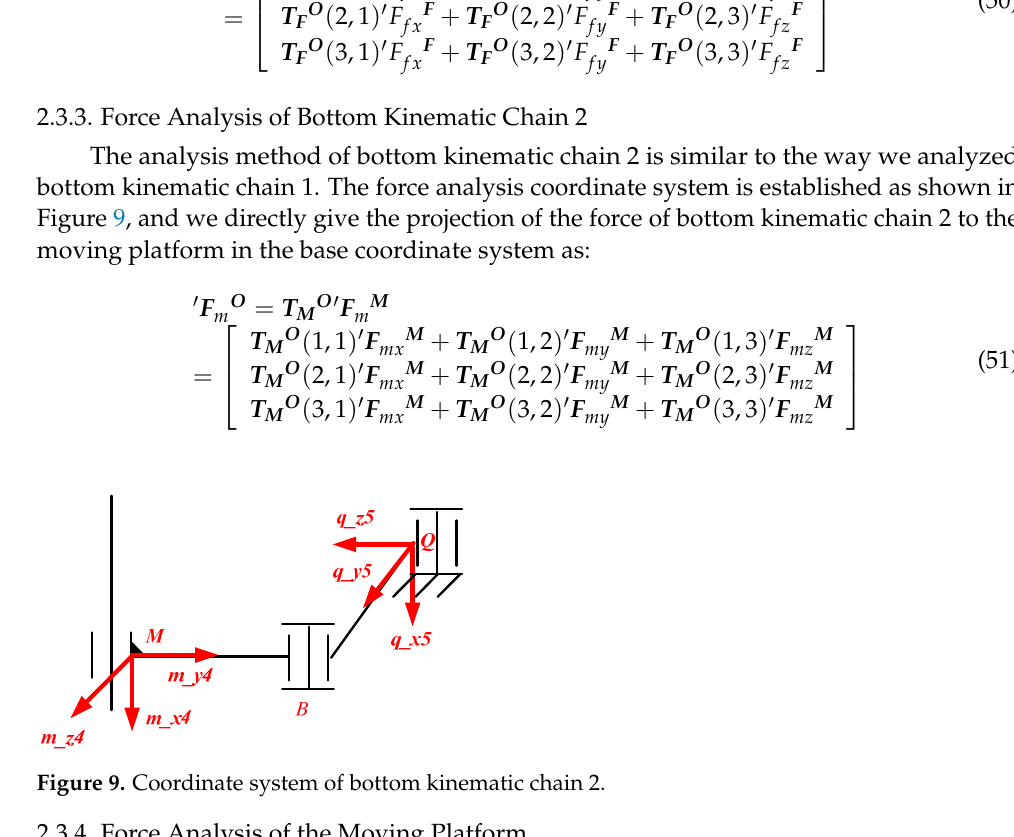
Table 1. Parameters of static model.